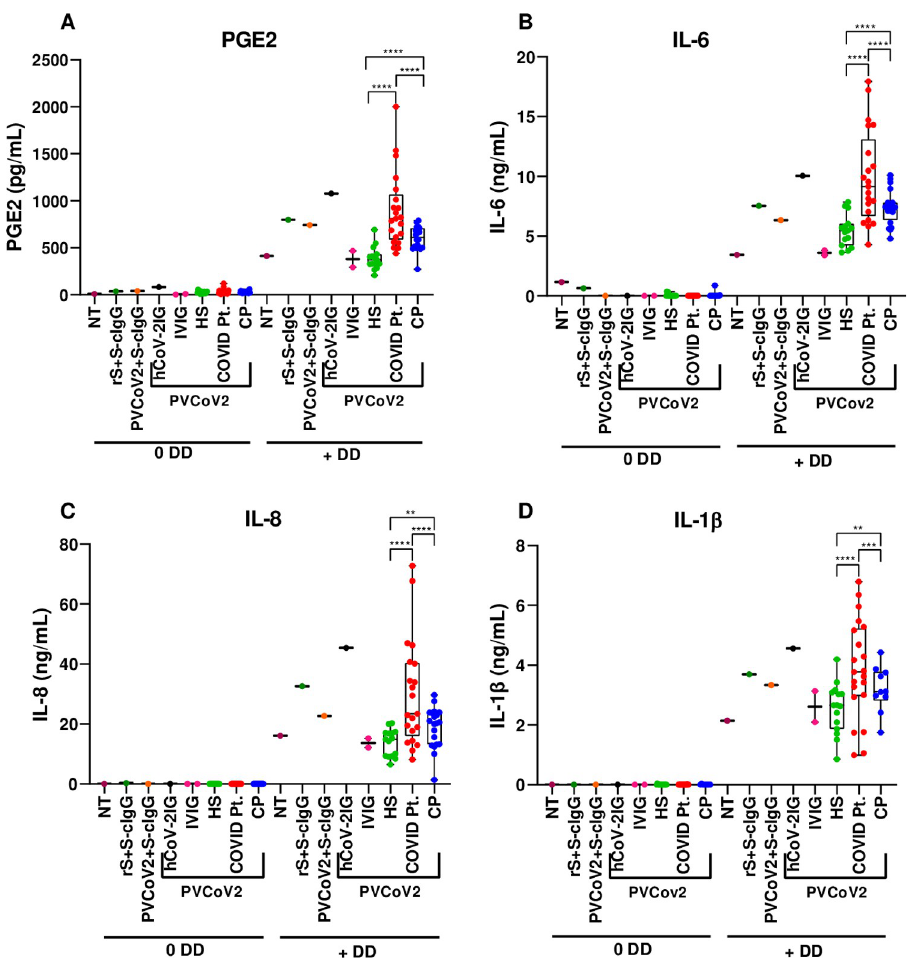
Fig 5. IC of SARS-CoV-2 pseudovirus with plasma from COVID-19 patients but not from healthy subjects induced PGE2, IL-6, IL-8, and IL-1 β in monocytes in the presence of DD. Monocytes were left not treated (NT) or were incubated with rS+S-cIgG IC, with PVCoV-2+S-cIgG IC, or with IC of PVCoV-2 coated with hCoV-2IG (N = 1), IVIG (N-2), healthy subjects’ plasma (HS, N = 15), COVID-19 patients’ plasma (COVID Pt., N = 21), or convalescent plasma (CP, N = 20) alone (0 DD) or with 2 μ g/ml of DD (+ DD) (A-D). Cell culture supernatants were collected and PGE2 (A), IL-6 (B), IL-8 (C), and IL-1 β (D) concentrations were determined by FRET assay (A) and by ELISA (B-D). Mean PGE2 and IL-6, IL-8, and IL-1 β concentrations ± SD calculated for triplicate wells are shown for a representative of two experiments performed with cells from individual donors. �� P < 0.003, ��� P < 0.001, ���� P < 0.0001, by Kruskal-Wallis test with Dunn’s post-test comparison for individual